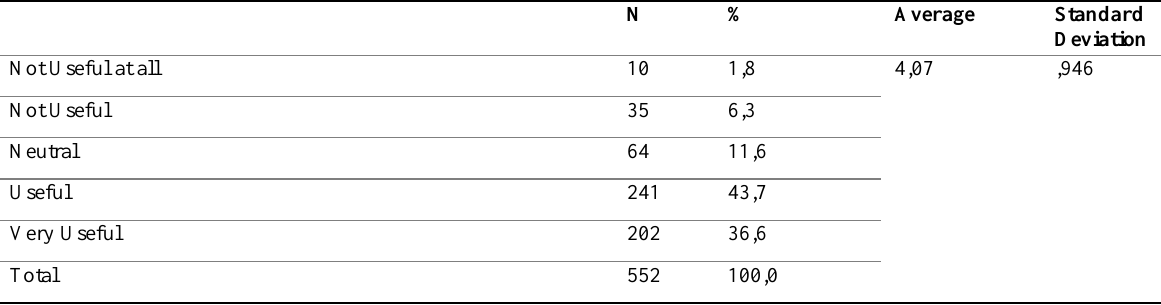
Table 8: General Evaluation on Training Activities for Service of Family Doctors / Specialists N %